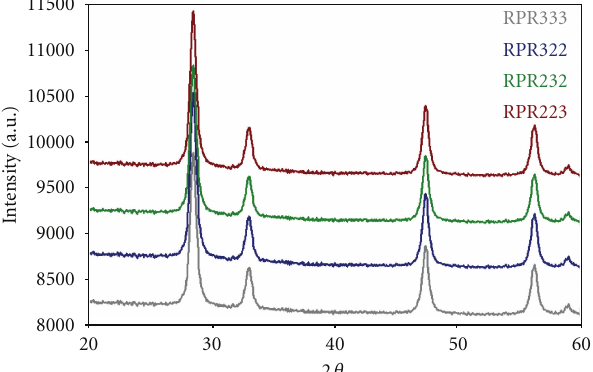
Figure 5: Comparative postsulfidation XRD patterns of the trimetal-supported catalysts after exposure to 1000ppm H 2 S/bal. N 2 stream at 800 ◦ C for 24